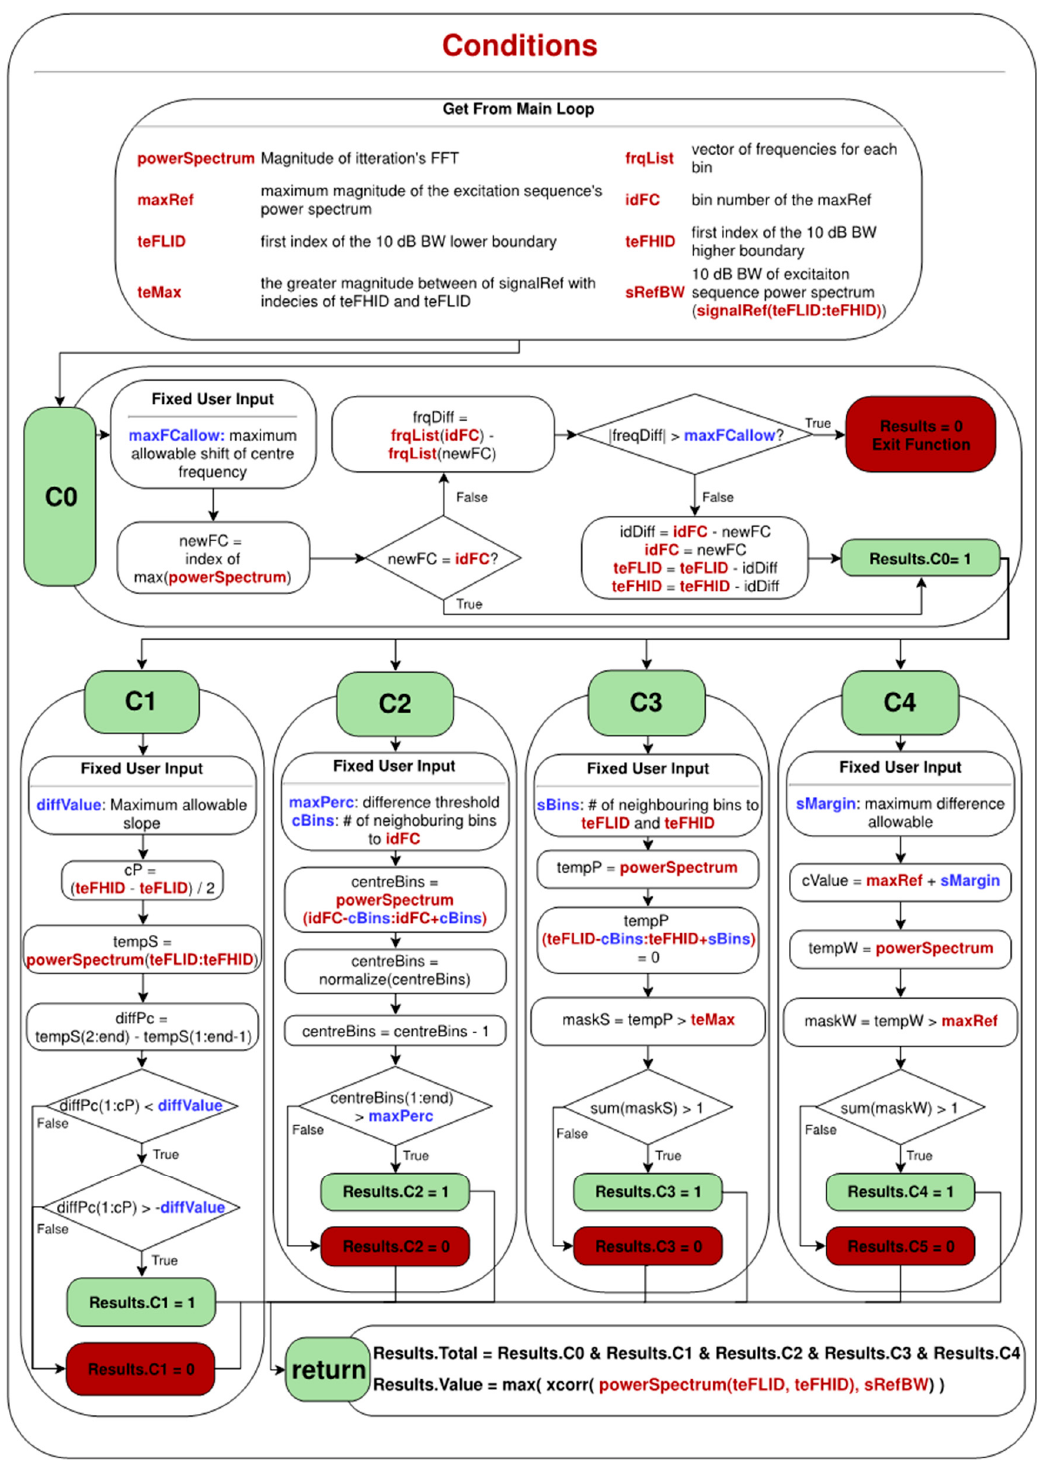
Figure 3. Flowchart of conditions.